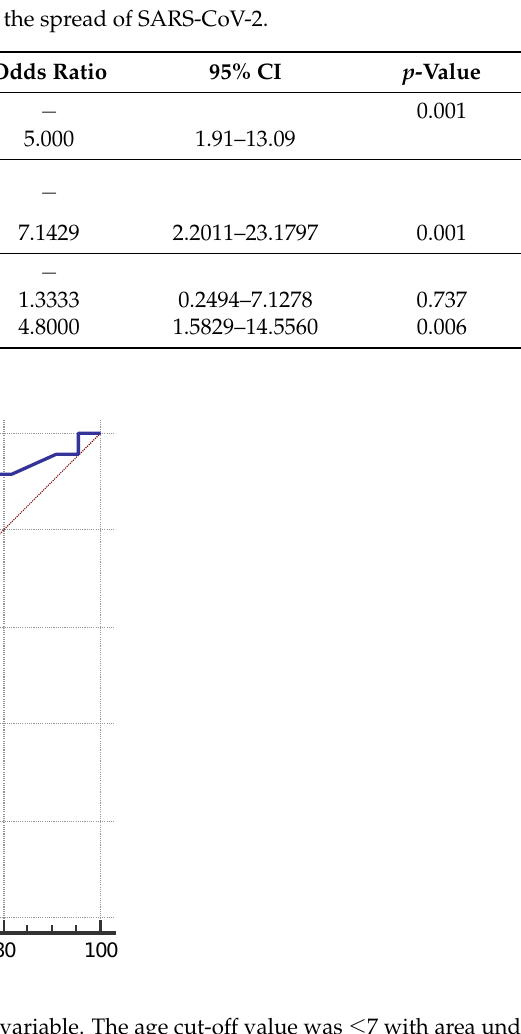
Figure 2. ROC curve for age as a continuous variable. The age cut-off value was ≤ 7 with area under the curve, sensitivity and specificity of 0.566, 83.3% and 50%, respectively. The dashed diagonal line corresponds to predictive value no better than chance.